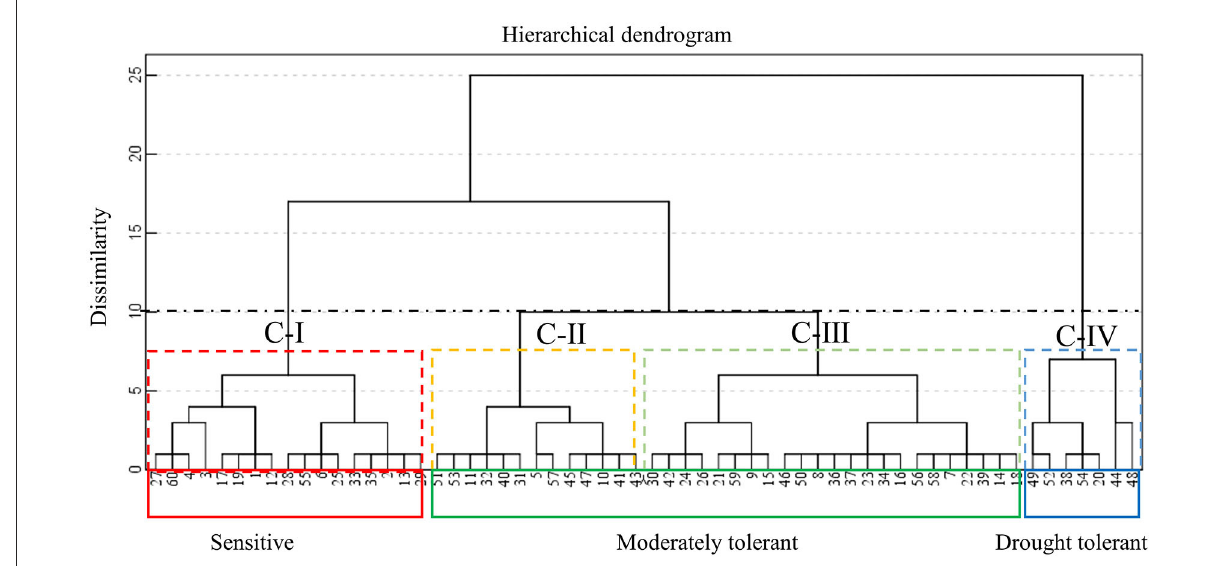
FIGURE5 Hierarchical cluster analysis of 60 soybean varieties based on euclidean distance of the average survival rate under twice drought rehydration treatments. Abbreviations of varieties are found in Table 1. Cluster IV (blue) (drought tolerant), Cluster I (red) (drought sensitive), Cluster II (yellow), and Cluster III (green) (moderately tolerant).